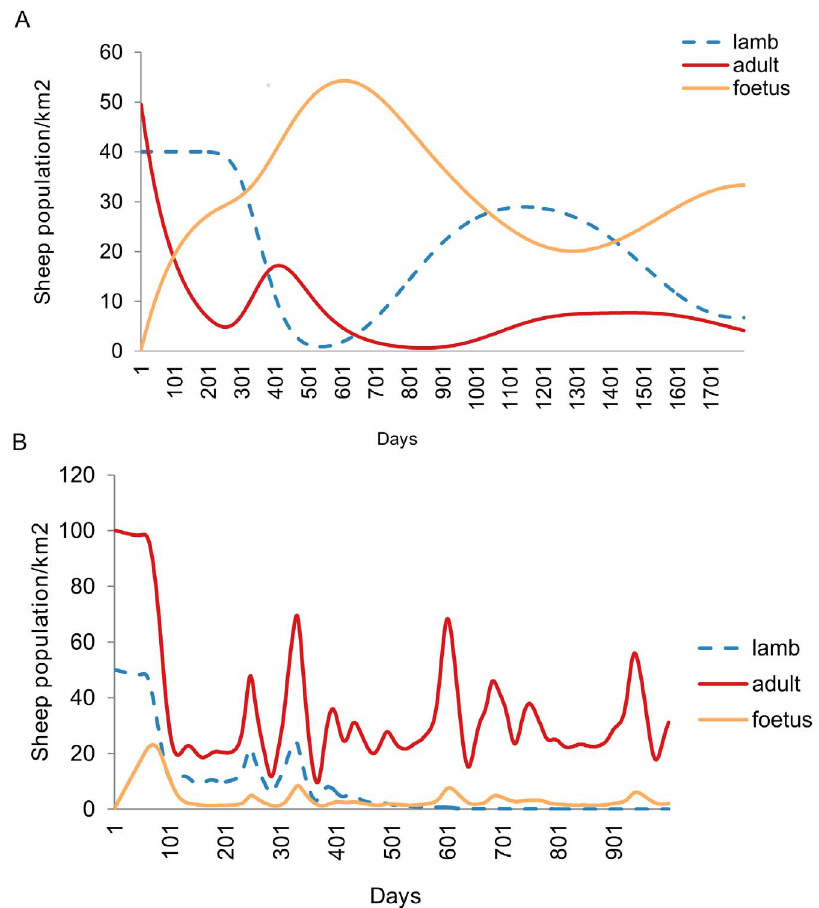
Figure 5. Sheep population dynamics controlled at the environmental carrying capacity of 200 sheep per square kilometre. (A) Growth stages without infection. (B Growth stages after introduction of controlled infection within Aedines mosquitoes only.